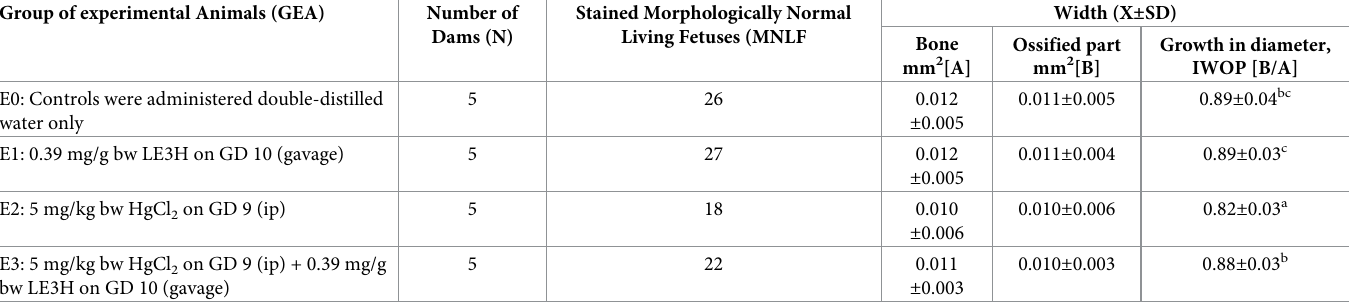
Table 4. Width of humerus bone of M . musculus fetuses on Gestation Day (GD) 18 which previously were given 0.39 mg/g bw LE3H through gavage on GD 10 (E1), injected with 5 mg/kg bw HgCl 2 on GD 9 (E2), and administered 5 mg/kg bw HgCl 2 on GD 9 and then 0.39 mg/g bw LE3H on GD 10 (E3). Meanwhile, the controls (E0) were administered double-distilled water only. Group of experimental Animals (GEA)